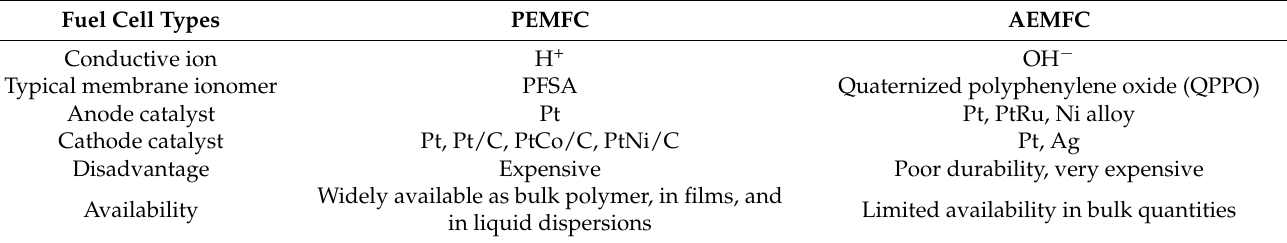
Table 1. Characteristics and components of PEMFC and AEMFC.